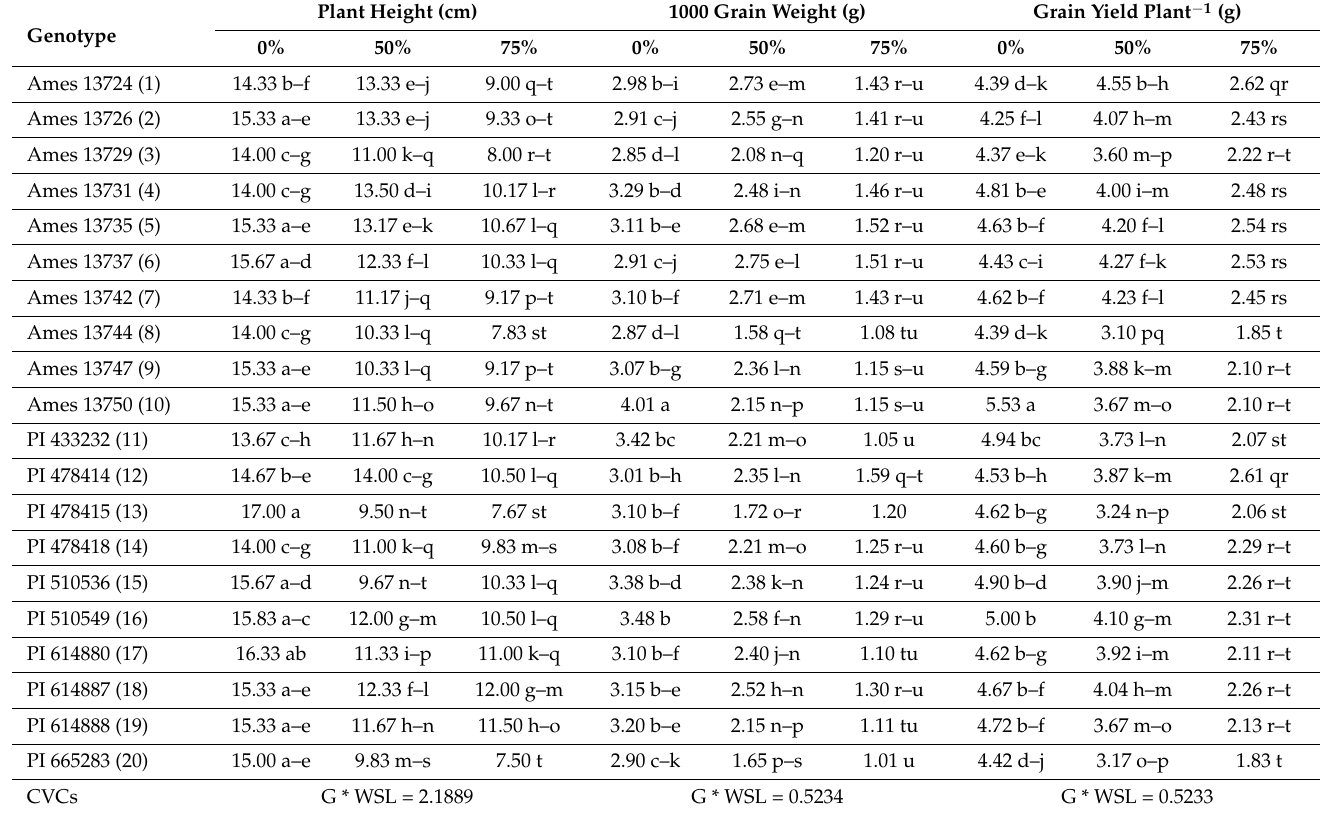
Table 4. Yield parameters of quinoa genotypes under varying water deficit